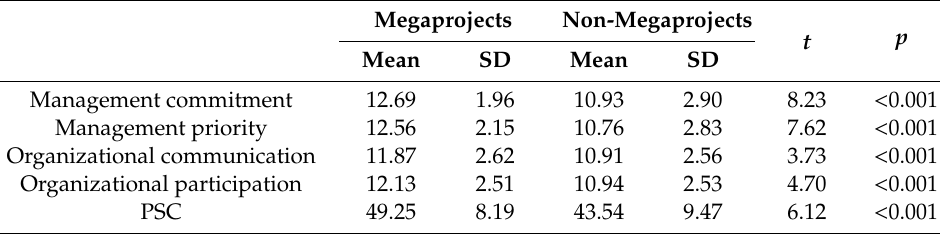
Table 6. Descriptive statistical results of the PSC